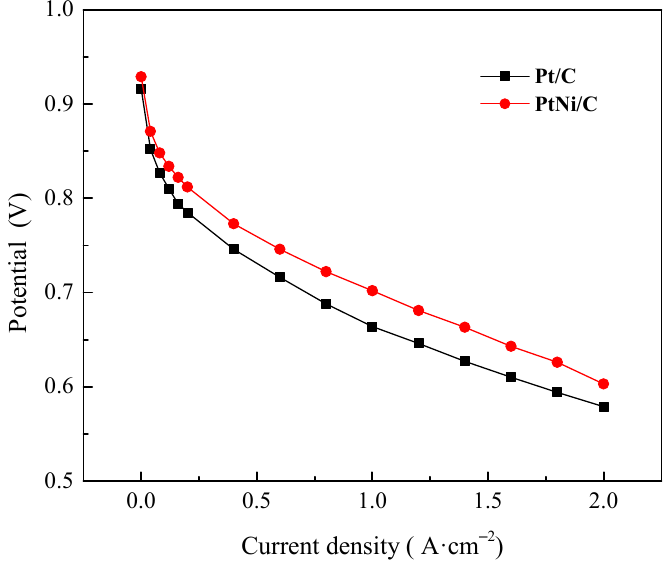
Figure 8. The single cell performance curves of PtNi/C and JM-Pt/C catalysts.